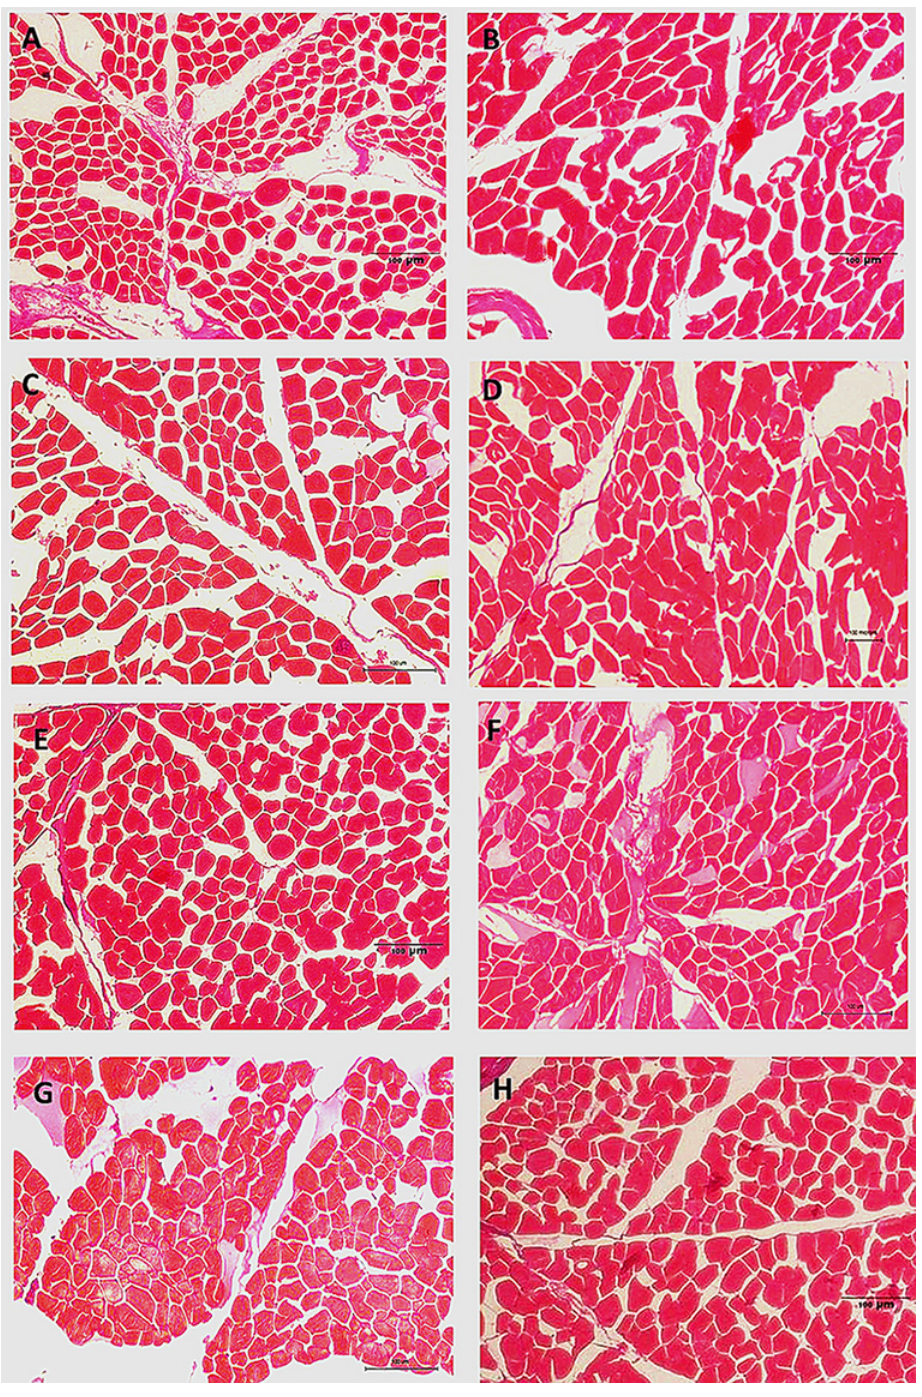
Fig 3. Effects of GHRP-2 and CS on the myofiber parameters in yaks with growth retardation A, B, C and D represent Longissimus dorsi samples in the NG, GG, CG and PG, respectively; E, F, G and H represent the semitendinosus samples in the NG, GG, CG and PG, respectively; Each picture was obtained via microscope with 200 x magnification.